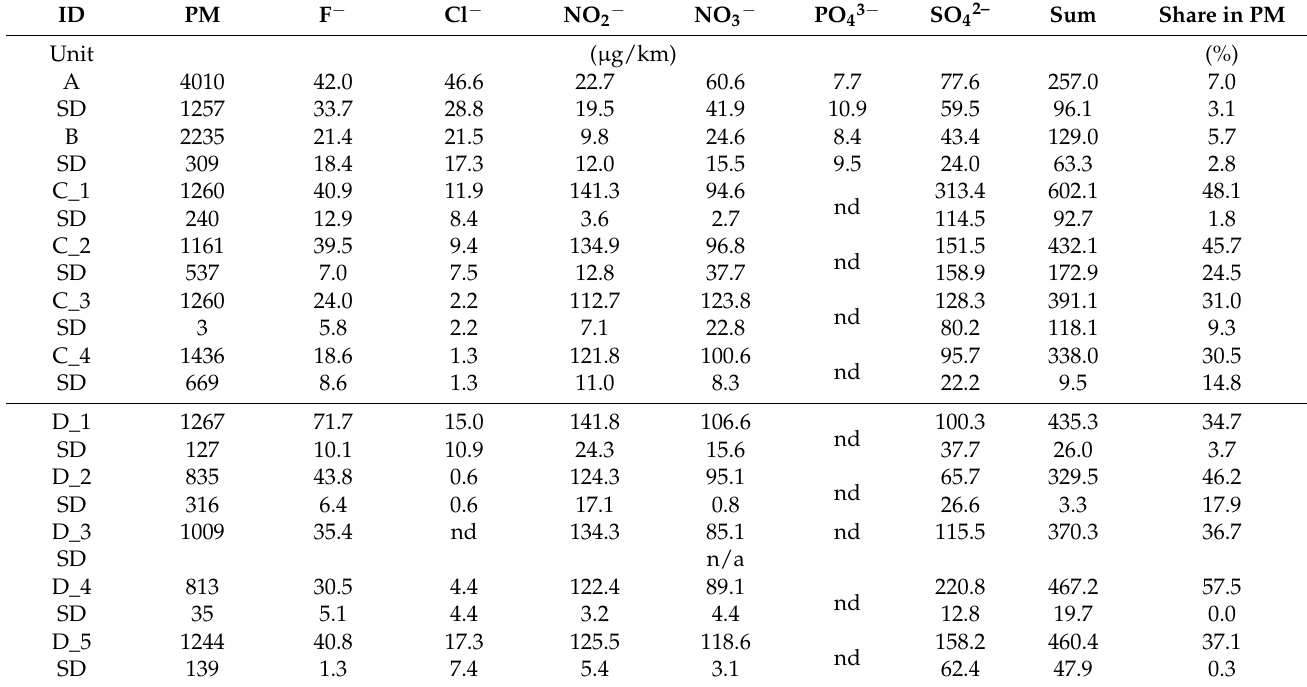
Table 9. The emission of the studied anions from the A–D vehicle groups. The mean emission and standard deviation are based on several analyses with the use of